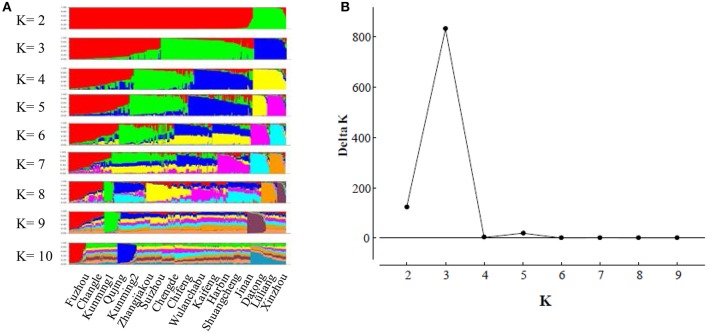
The evaluation of population admixture in the Alternaria alternata population from China using Structure. (A) The distribution of isolate assignment for number of clusters (K) ranging K from 2 to 10; (B) The estimated Delta K (ΔK) for number of clusters ranging from 2 to 9.